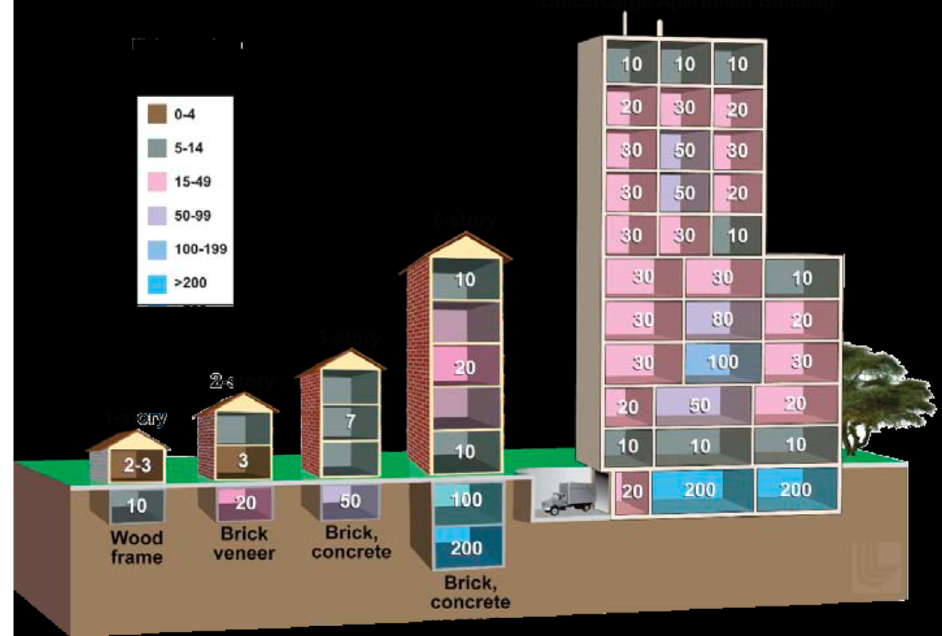
Figure 2. Protection Factors by building type and location within the building.